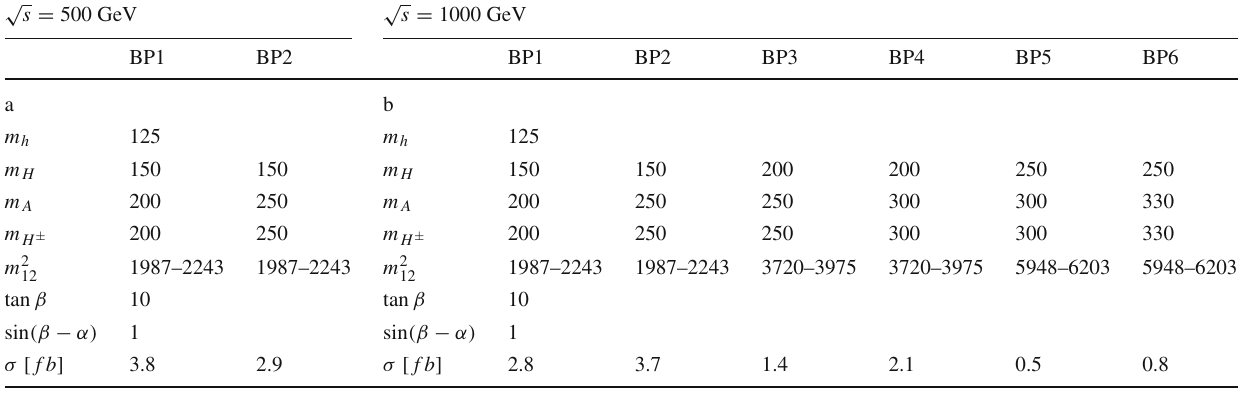
Table 3 Benchmark points assumed for the center-of-mass energies of a 500 and b 1000 GeV. m h , m H , m A and m H ± are physical masses of the Higgs bosons and the provided m 2 √ s = 500 GeV